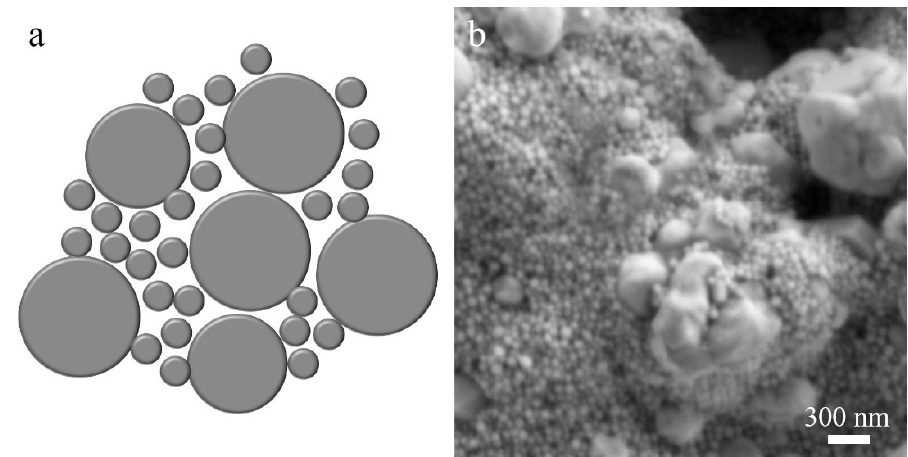
Figure 1. The Ag NP composite: ( a ) the schematic diagram; ( b ) the SEM image.